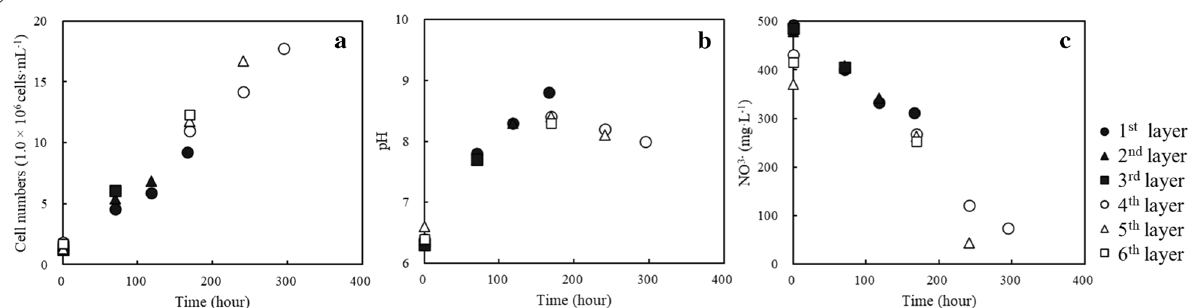
Fig. 3 Broth condition of C. reinhardtii in each culturing system Time-course profiles of a cell number, b pH, and c nitrate concentration are shown as closed circle (1st layer), closed triangle (2nd layer), closed square (3rd layer), opened circle (4th layer), opened triangle (5th layer) and opened square (6th layer). Harvested points were 70 h (1st layer), 118 h (2nd layer), 166 h (3rd layer), 169 h (4th layer), 241 h (5th layer) and 295 h (6th layer),